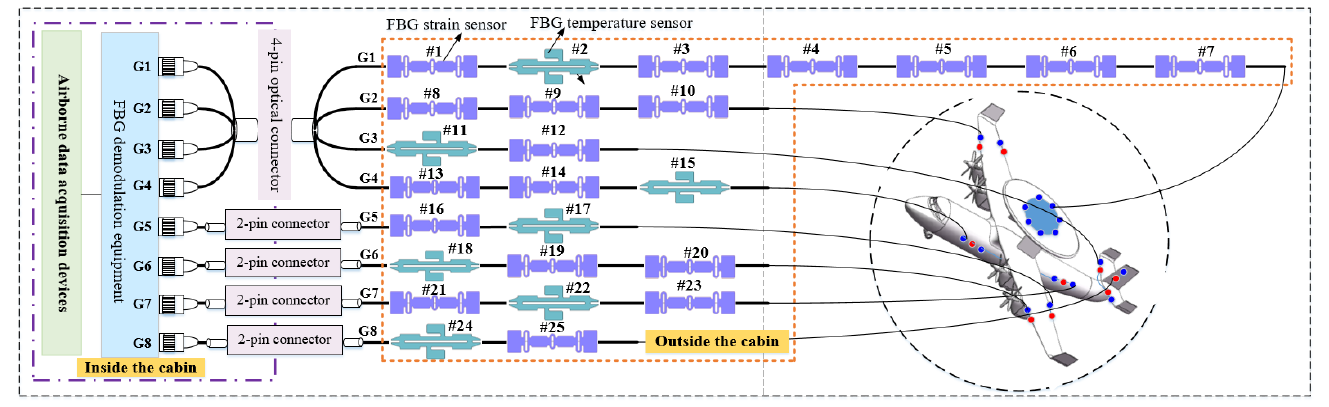
Figure 1. Diagram of the FBG sensing system on the plane.